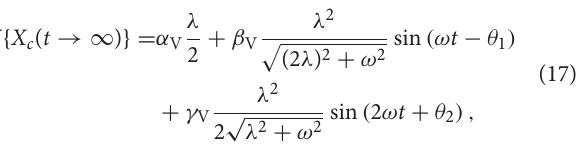
of a sinusoidally varying diet, we can solve for X c ( t ) directly,